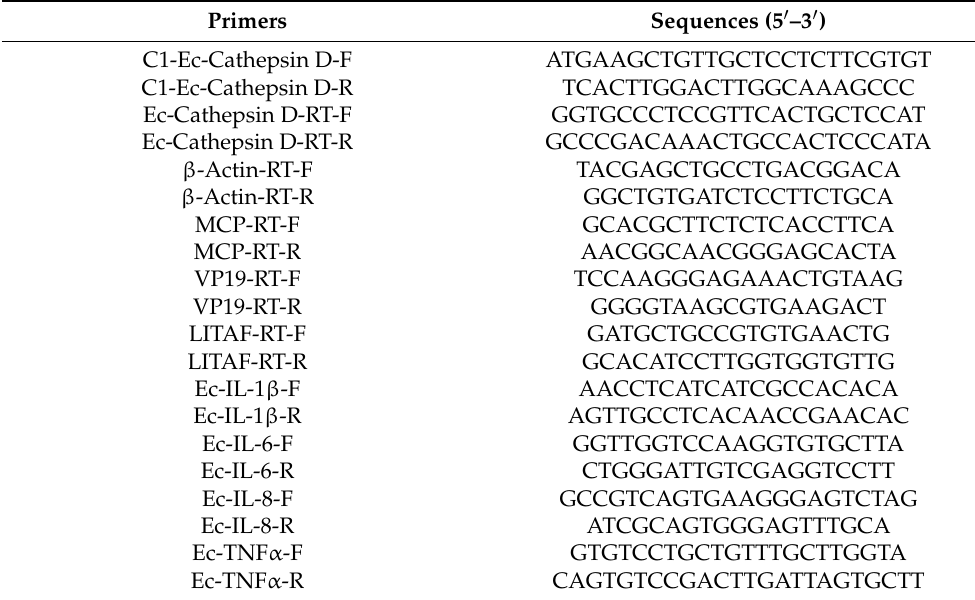
Table 2. Primers used for host and viral gene expression